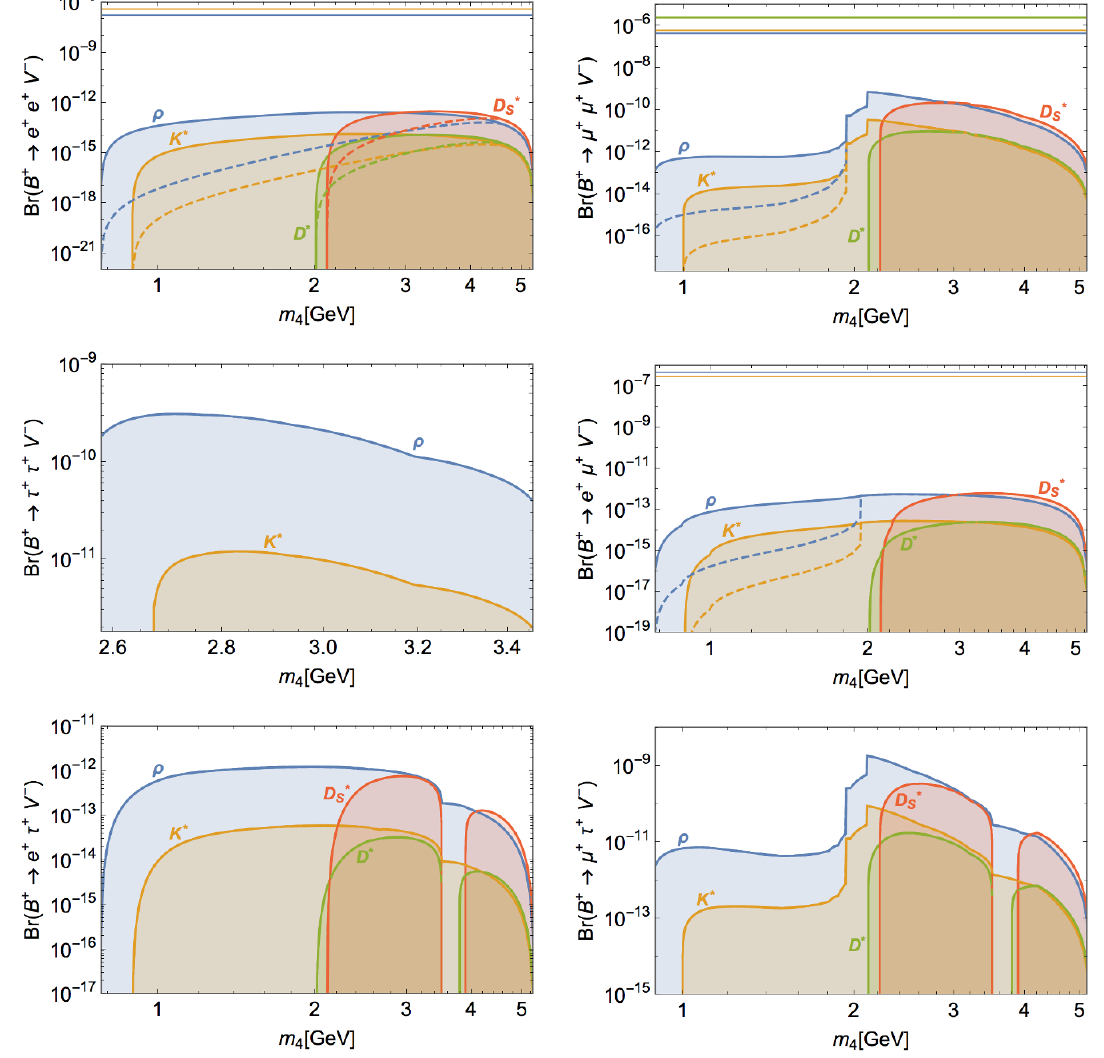
Figure 9 . Branching ratios of LNV decay modes of B + mesons (into vector (cid:12)nal states, plus leptons of same or di(cid:11)erent (cid:13)avour), as a function of the (mostly sterile) heavy neutrino mass, m 4 . Pale blue, yellow, red and green curves (surfaces) respectively denote the maximal (allowed) values of the BR( B + ! ‘ (cid:11) ‘ (cid:12) V (cid:0) ), with V (cid:0) = (cid:26) , K (cid:3) , D (cid:3) and D (cid:3) ; coloured dashed curves denote the s corresponding maximal values of the BRs once c(cid:28) 4 (cid:20) 10 m is imposed. The coloured horizontal lines correspond to the present experimental bounds, when available (cf. table 2).